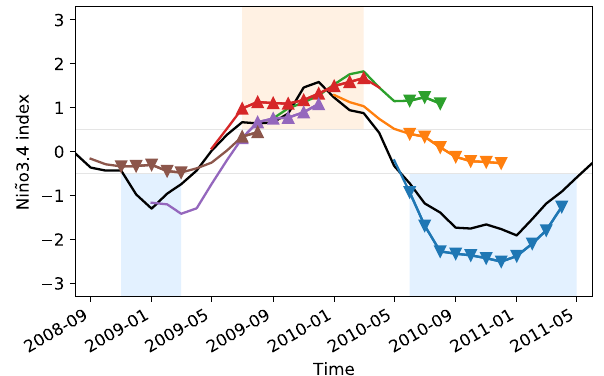
Fig. 6 Illustration of El Niño and La Niña onset forecasts. For the 2010/11 El Niño/La Niña events we show some example forecasts from the cm4i model. The El Niño and La Niña events are de fi ned from observations and denoted by red and blue shading respectively. To qualify as an El Niño/La Niña onset forecast, the forecast must have been initiated before the event occurred in observations (prior to and outside the red/blue area) and contain lead times that land during the period of the observed event (red/ blue area). The model forecasts that land in the El Niño event time window are denoted by upward triangles and constitute the set of forecasts used to assess onset for the El Niño event shown. These may or may not correspond to El Niño events in the models. The set of forecasts that qualify for La Niña onset here are denoted by downward